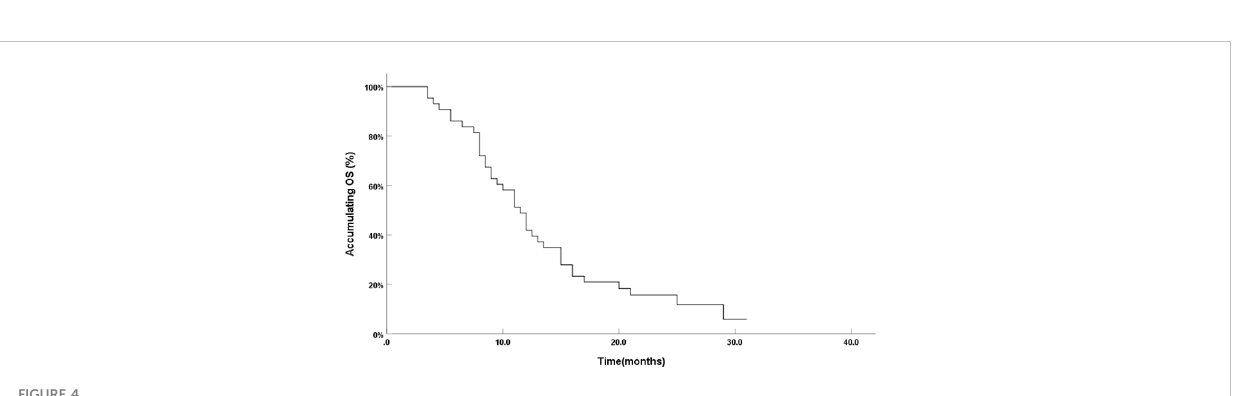
FIGURE 4 Survival curve of 43 patients with refractory NSCLC.